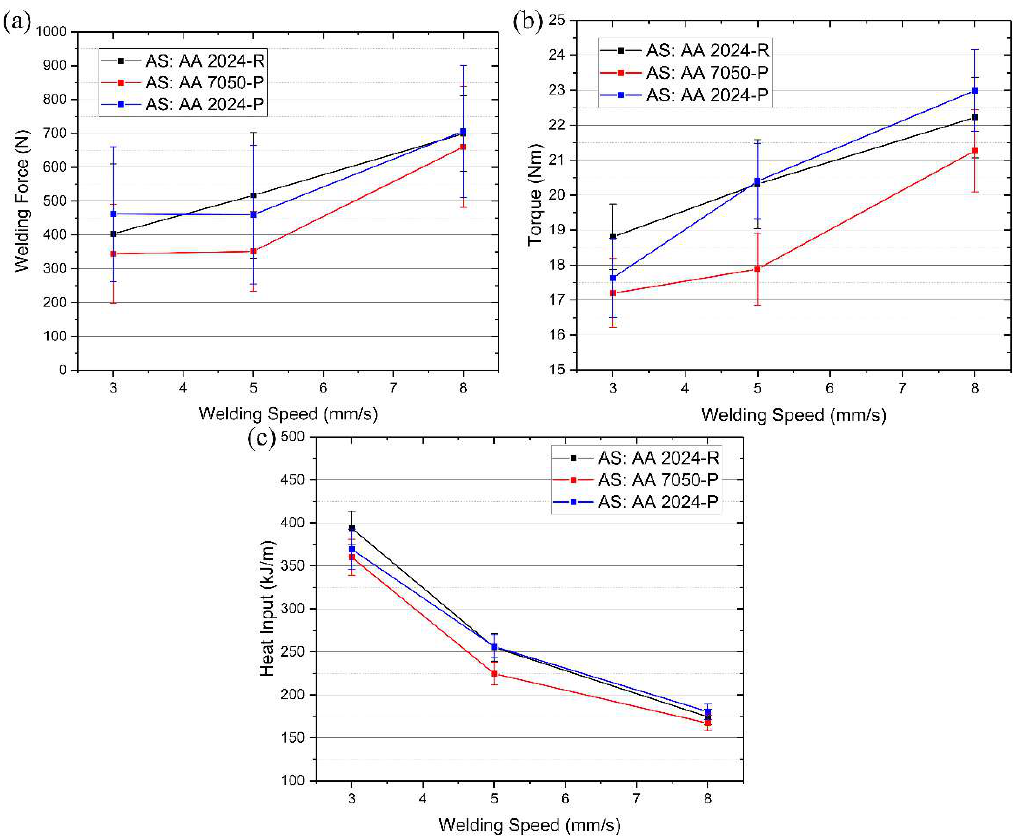
Figure 13. Measured: ( a ) Welding force, ( b ) Torque and ( c ) calculated energy input for the different material orientations.